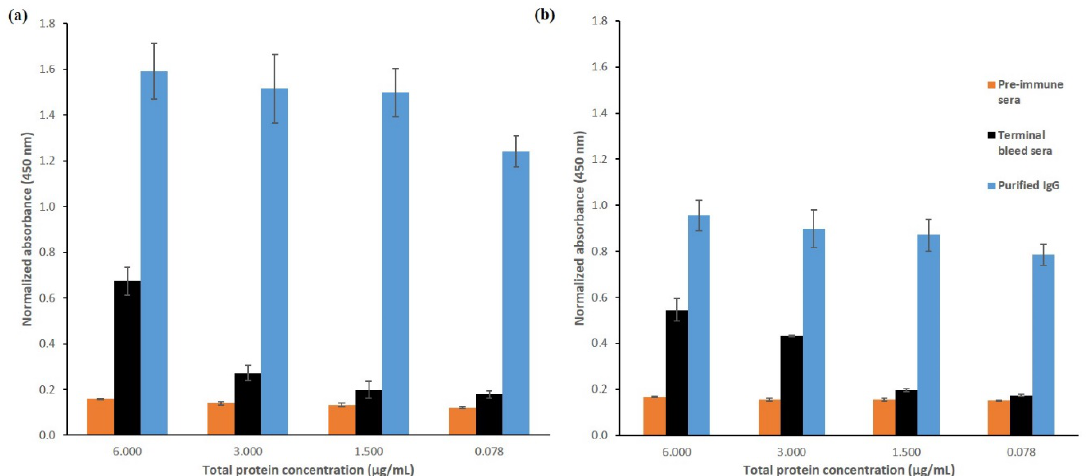
Figure 4. Comparison between binding of purified IgG, terminal bleed and preimmune sera from rabbits immunized with ( a ) Nter-KLH, ( b ) Cter-KLH.